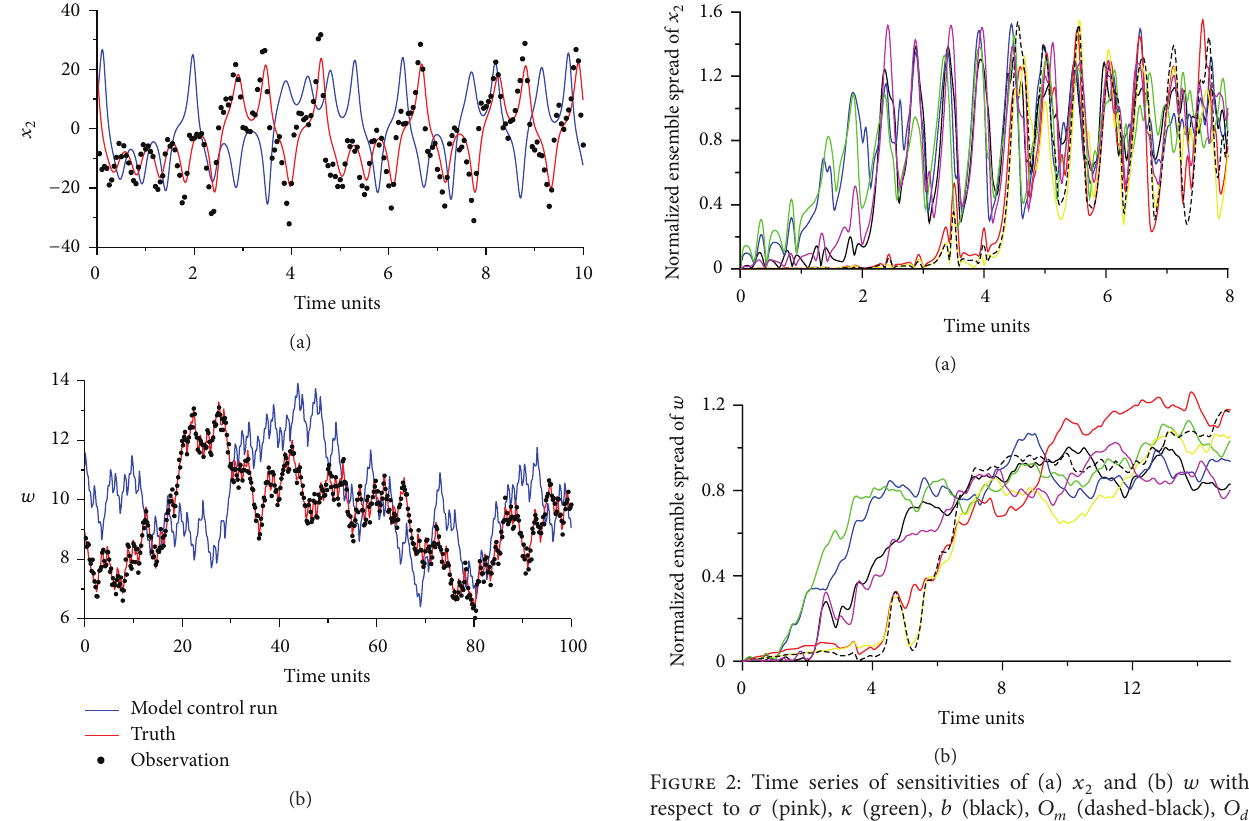
Figure 1: Time series of (a) 𝑥 2 for the first 10TUs and (b) 𝑤 for 100TUs of the assimilation period derived from the truth (red), model control run (blue), and observations (black solid circle), respectively.